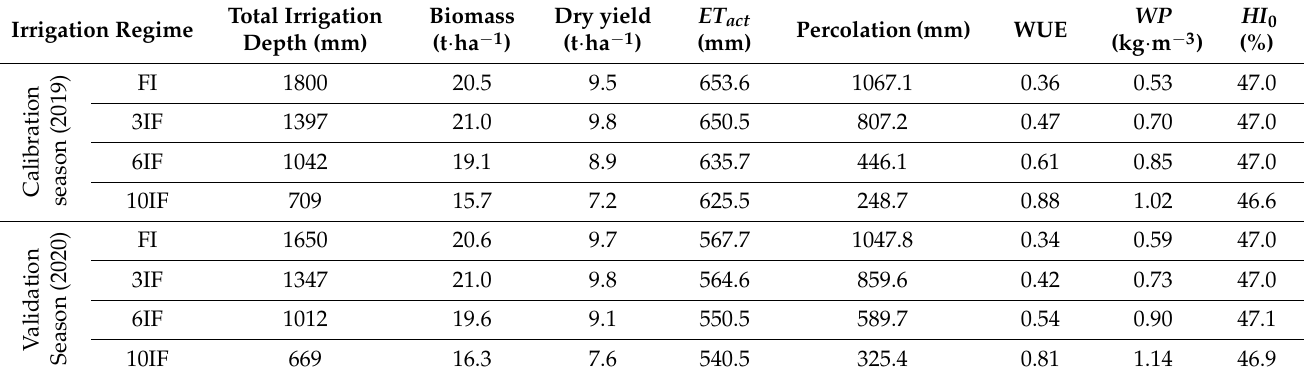
Table 3. Average of total irrigation water, biomass, dry yield, actual evapotranspiration, water use efficiency, water productivity, and harvest index during the growing seasons (2019 and